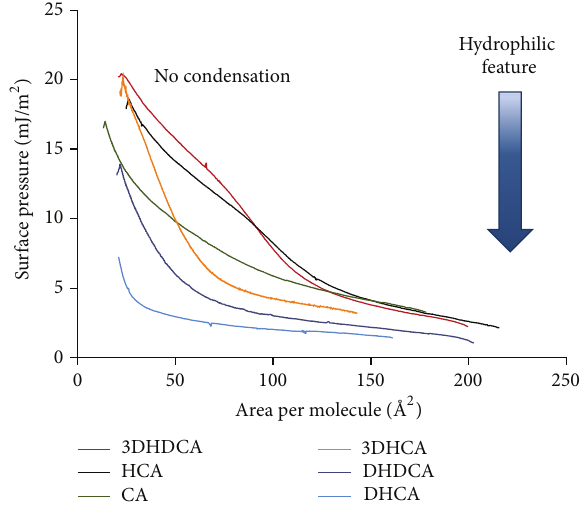
Figure5: Compressionisothermsof3DHDCA, HCA, CA,3DHCA, DHDCA, and DHCA measured on 3 M NaCl at pH = 1.2 aqueous subphase at 25±0.1 ∘ C. Increasing hydrophilicity of BAs is indicated by the arrow. Surface pressure unit is expressed in mJ/m 2 instead of the commonly applied